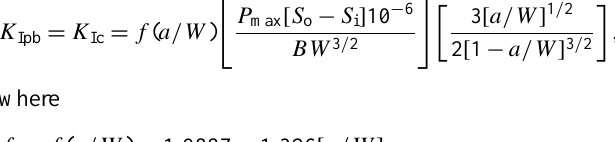
data as a function of time during a fracture experiment. The vertical thin black line represents the time at